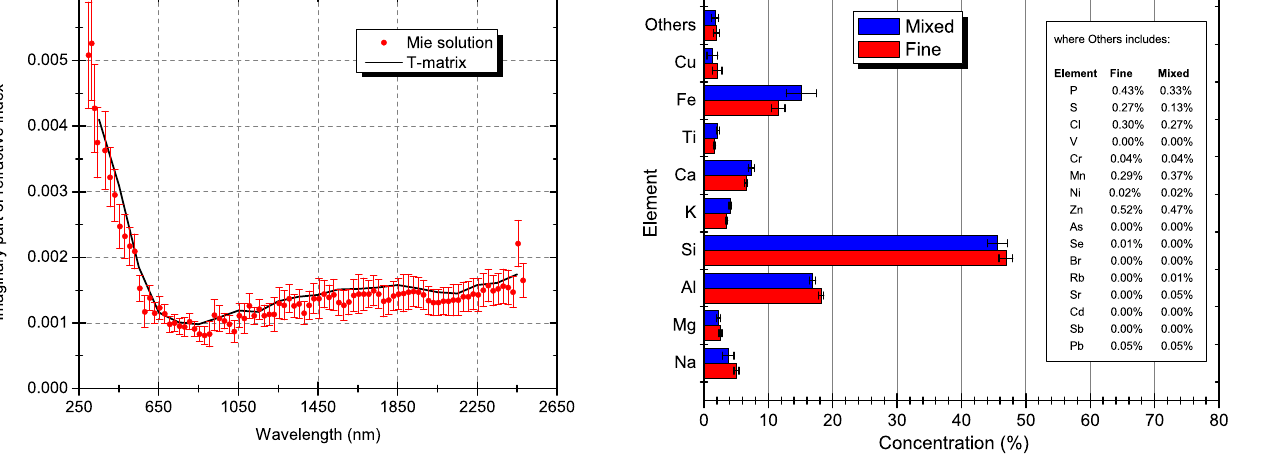
NaMgAlSiKCaTiFeCuOthers